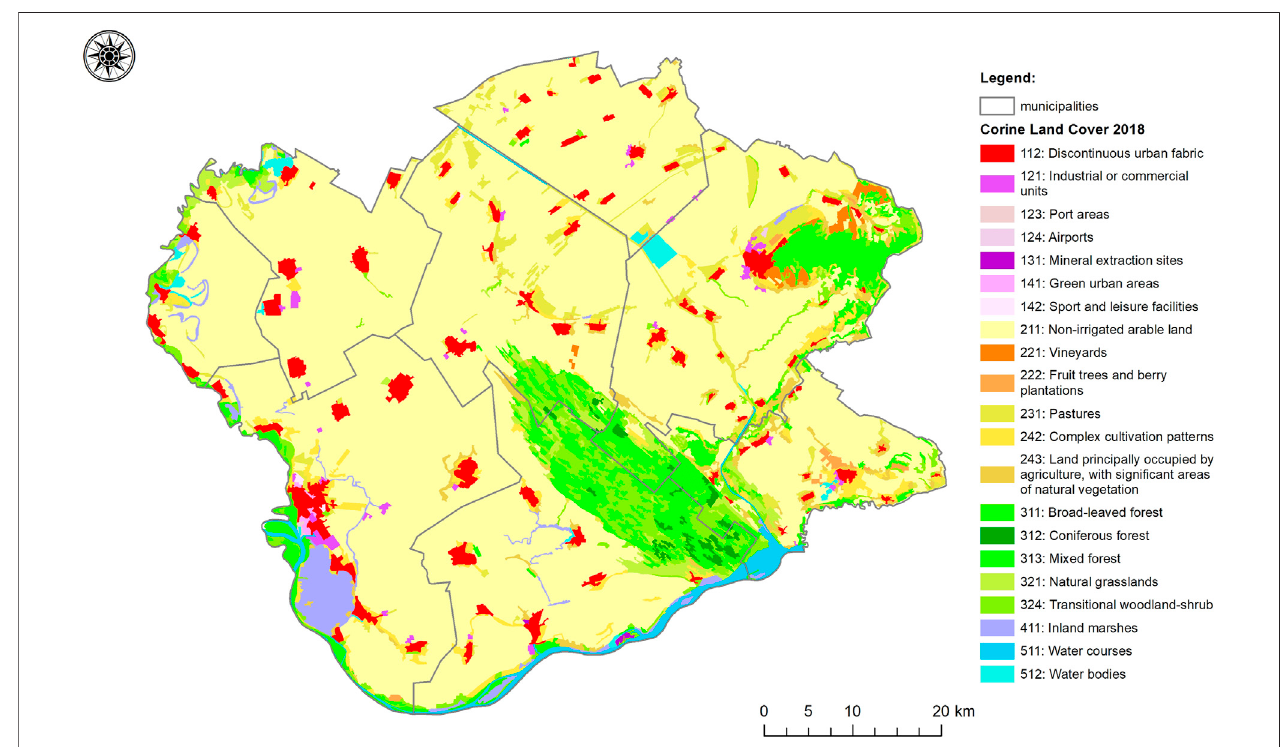
FIGURE 4 | Land cover in 2018.